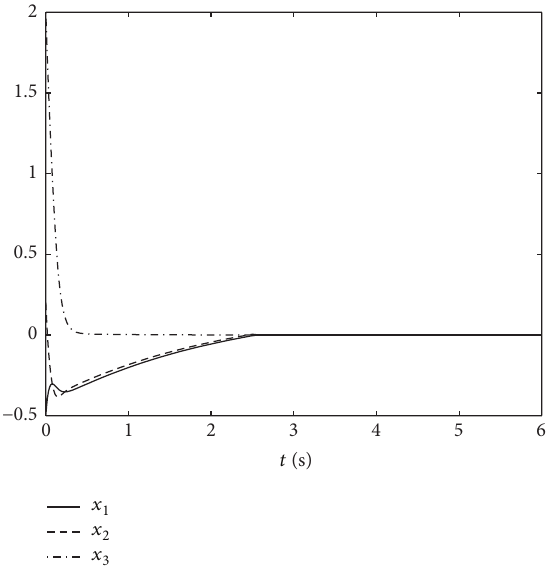
Figure 2: Response of the states of the closed-loop system (1).